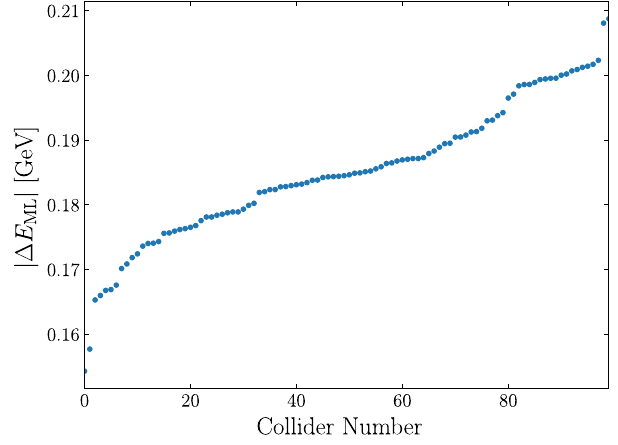
j that corresponds to a ML